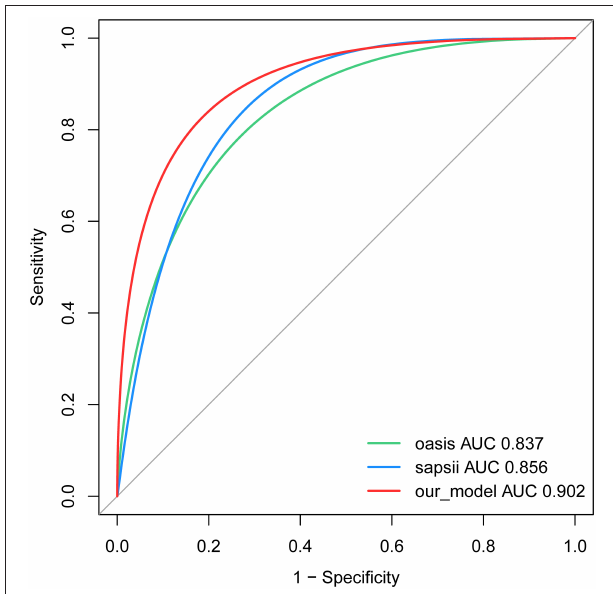
FIGURE 4 | Receiver operating characteristic curve of the nomogram. AUC, area under curve; OASIS, oxford acute severity of illness score; SAPS II, simplified acute physiology score